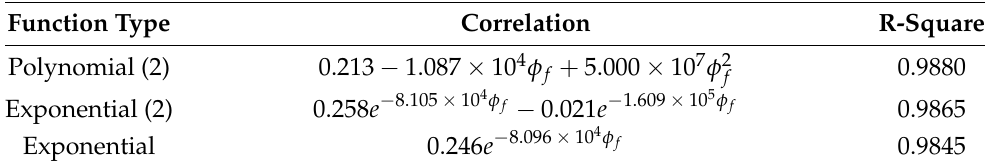
Table 2. Correlations to predict the effective mass diffusion coefficient of the GDLs as a function of the fiber